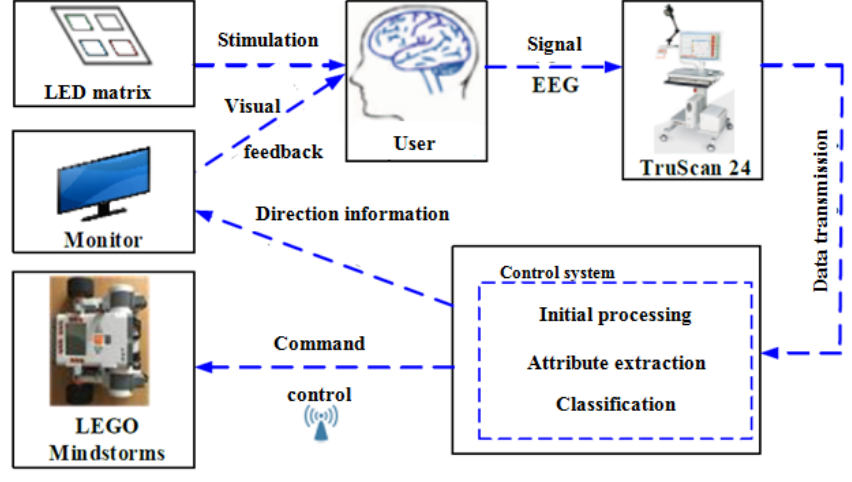
Figure 2. Structural scheme of the BCI system being designed.